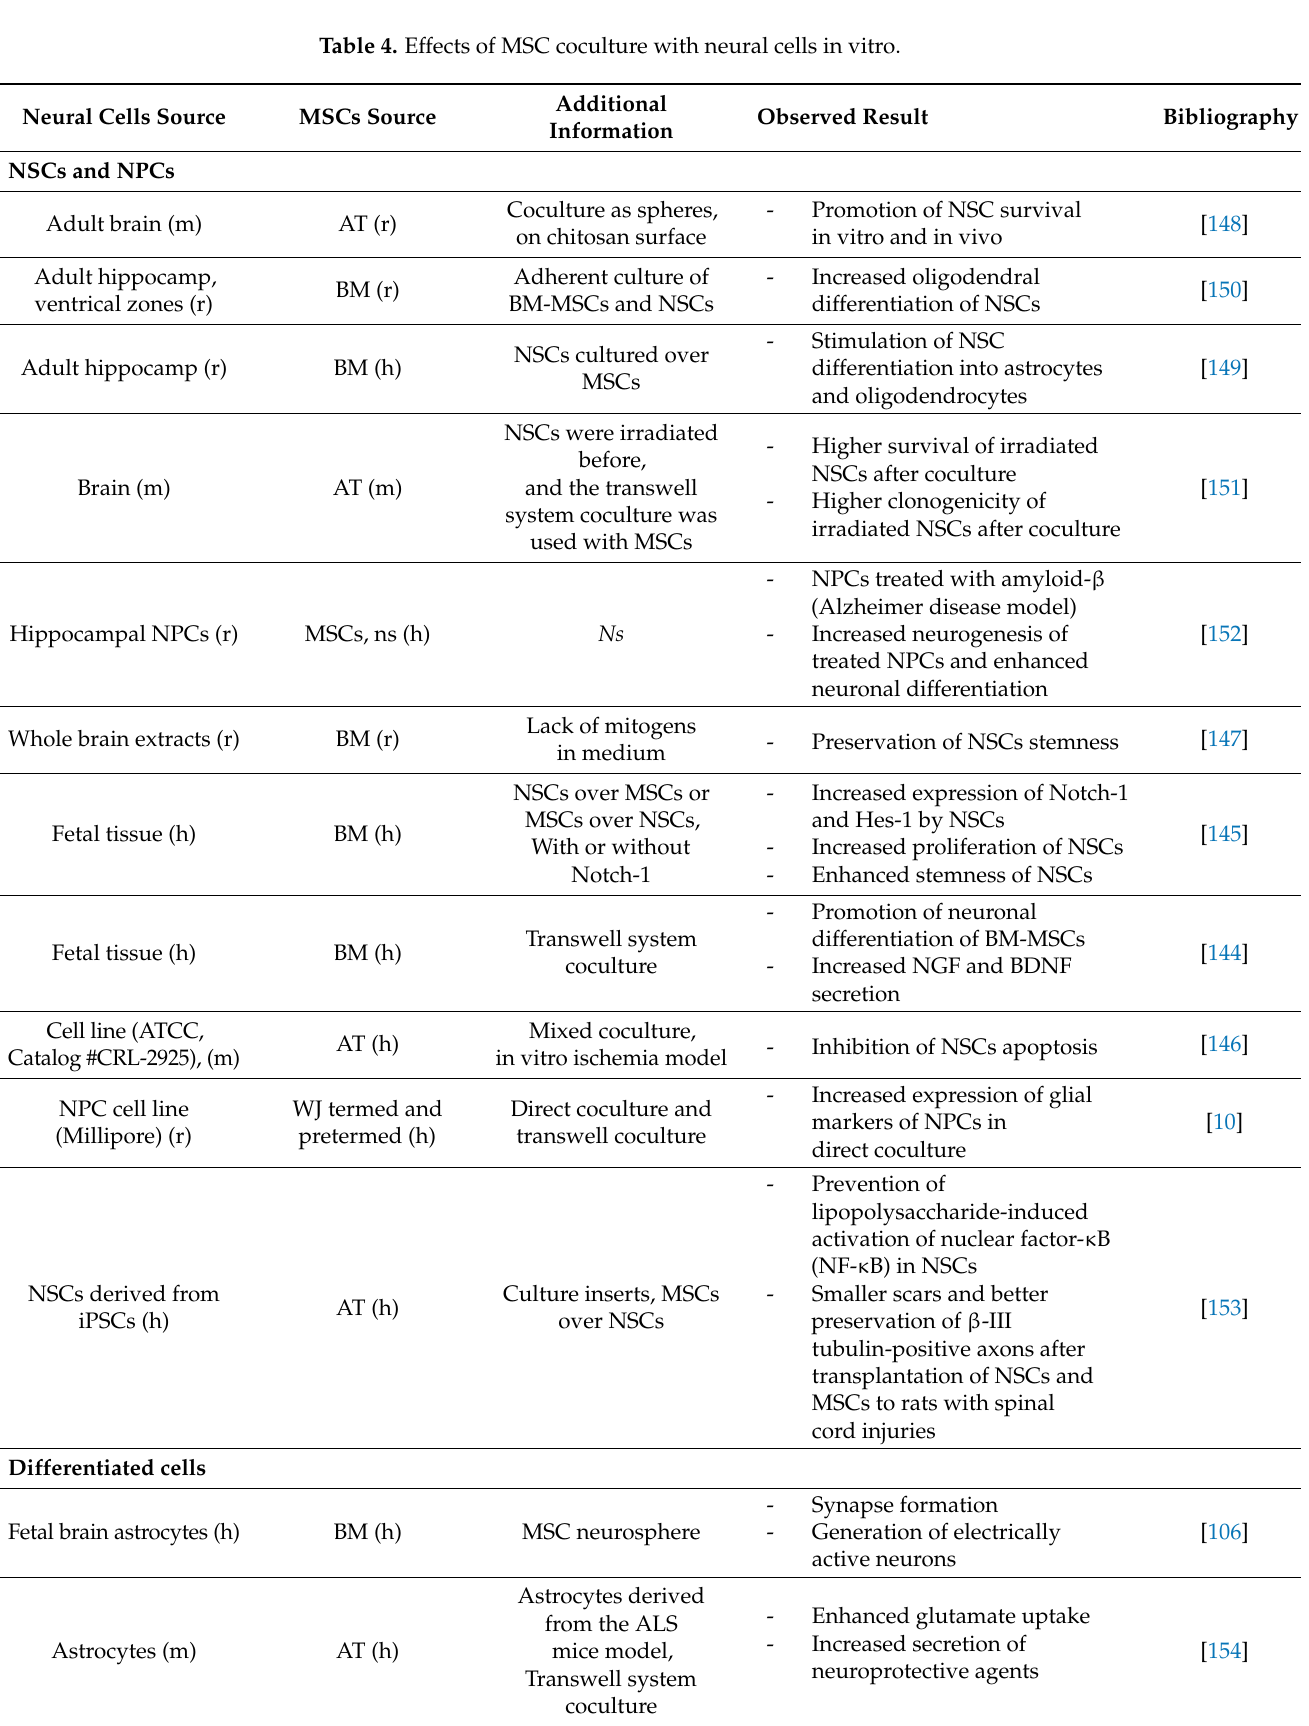
Table 4. Effects of MSC coculture with neural cells in